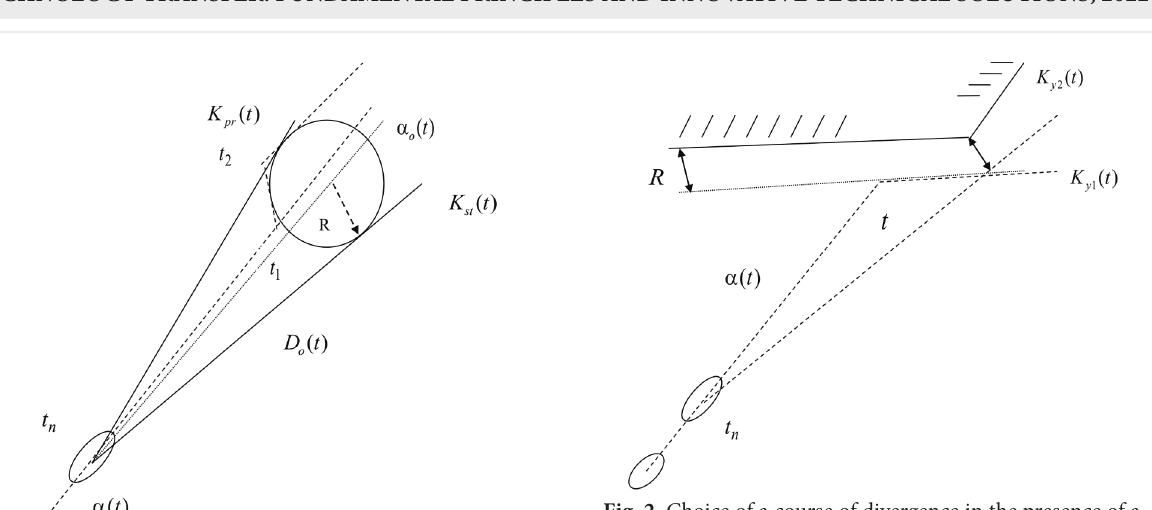
Fig. 2. Choice of a course of divergence in the presence of a linear distributed